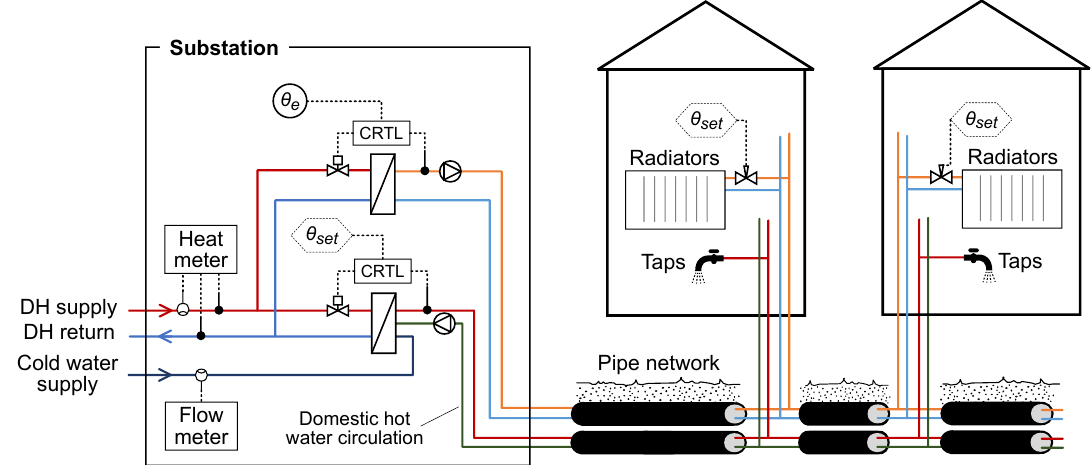
Figure 4. District heating substation serving multiple